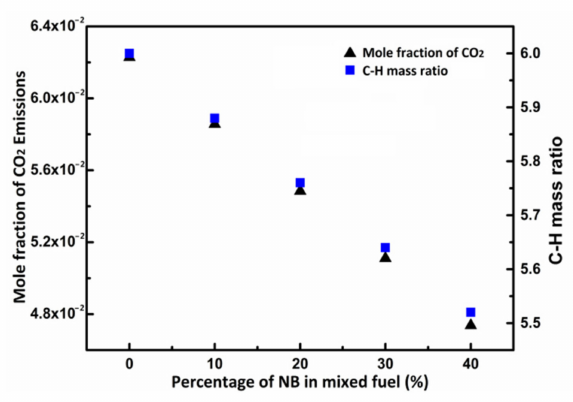
Figure 17. Effect of n-butanol percentage on C-H mass ratio and final CO 2